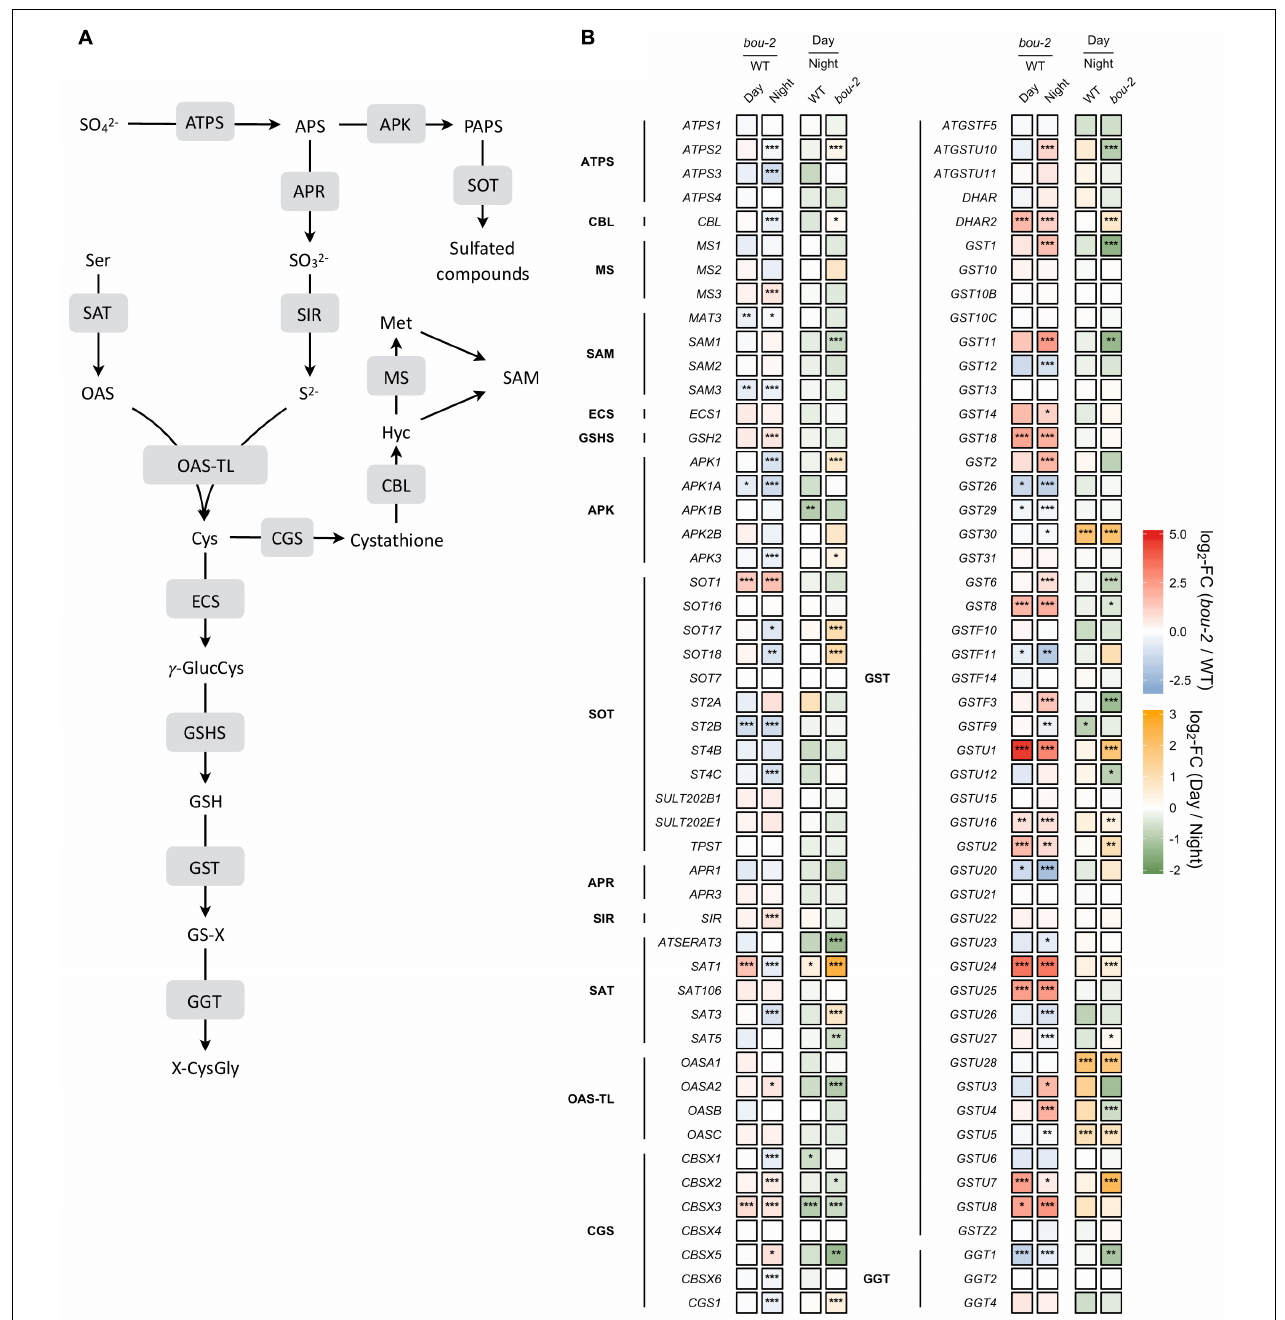
FIGURE 7 | Schematic presentation (A) and transcript levels ( B , n = 3) of genes involved in leaf sulfur metabolism. Left two tiles of each gene represent the log2- fold change (FC) between the bou-2 mutant and the WT plants at both day (D) and night (N) with false color code ranging from red (higher in bou-2 ) to blue (higher in WT). Right two tiles represent the log2-fold change (FC) between day and night within the WT plants and the bou-2 mutant with false color code ranging from green (higher at night) to yellow (higher at day). Asterisks indicate differential gene expression as determined by Sleuth ( ∗ FDR < 0.05, ∗∗ FDR < 0.01, and ∗∗∗ FDR < 0.001). APS, adenosine 5 (cid:48) - phosphosulfate; Cys, cysteine; Cyst, cystathionine; Glu, glutamate; γ -GluCys, γ -glutamylcysteine; GSH, glutathione; GS-X, glutathione conjugate; Hcy, homocysteine; Met, methionine; OAS, O-acetylserine; OPH, O-phosphohomoserine; PAPS, 3 (cid:48) -phosphoadenosine 5 (cid:48) - phosphosulfate; ROH, hydroxylated precursor; SAH, S-adenosylhomocysteine; SAM, S-adenosylmethionine; Ser, serine; Thr, threonine; X-CysGly, cysteinylglycine conjugate. Enzymes: ATPS, ATP sulfurylase; APK, APS kinase; SOT, sulfotransferase; APR, APS reductase; SIR, sulfite reductase; SAT, serine acetyltransferase; OAS-TL, OAS(thiol)lyase; CGS, cystathionine gamma-synthase; TS, threonine synthase; CBL, cystathionine beta-lyase; MS, methionine synthase; SAM, S-adenosylmethionine synthetase; ECS, gamma -glutamylcysteine synthetase; GSHS, glutathione synthetase; GST, glutathione-S-transferase; GGT, gamma-glutamyltransferase.